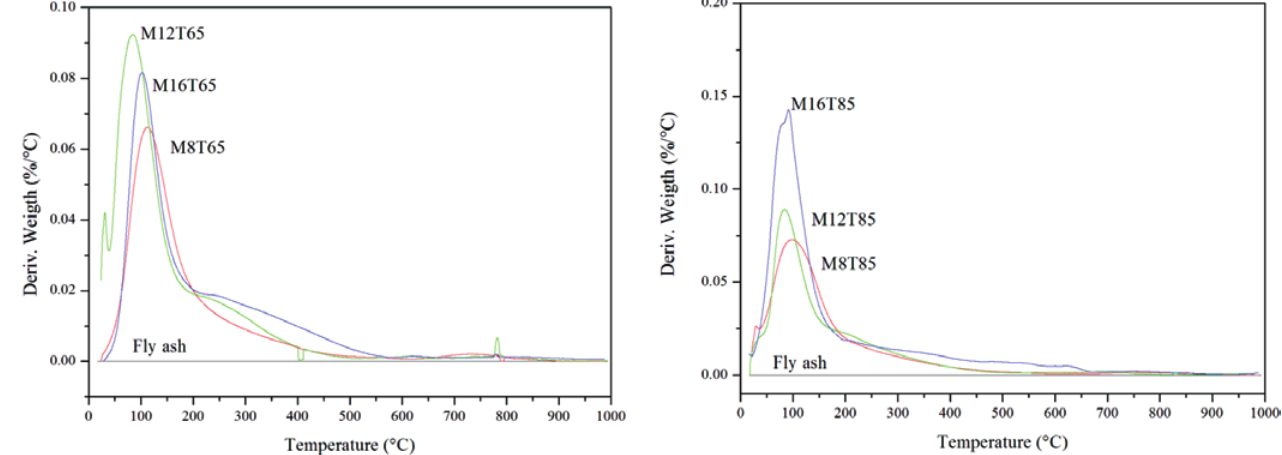
TThermograms (dTG) of fly ash and